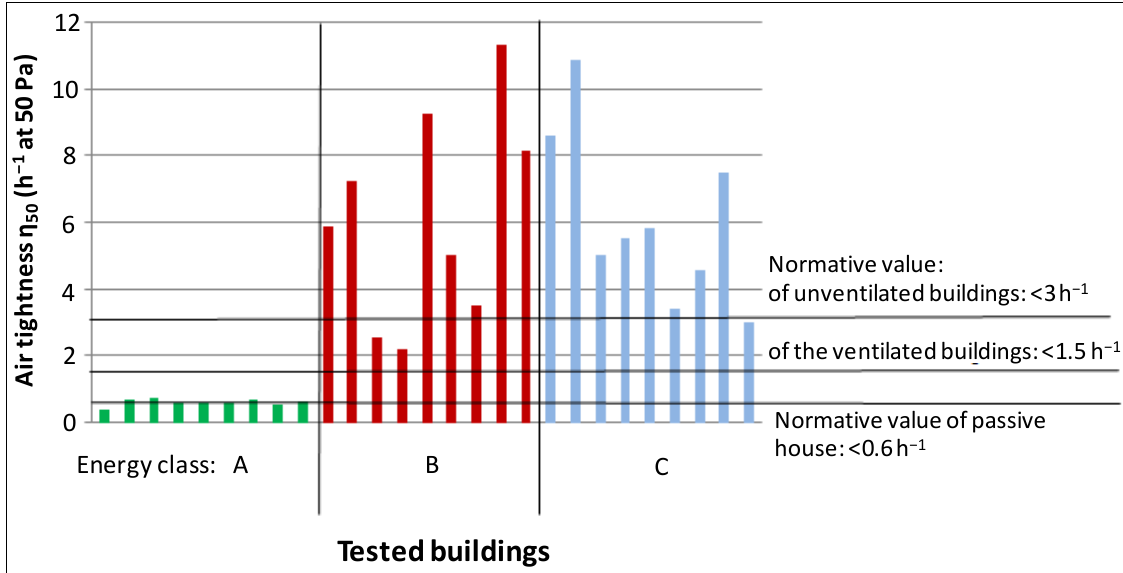
Figure 2. Air tightness of the research